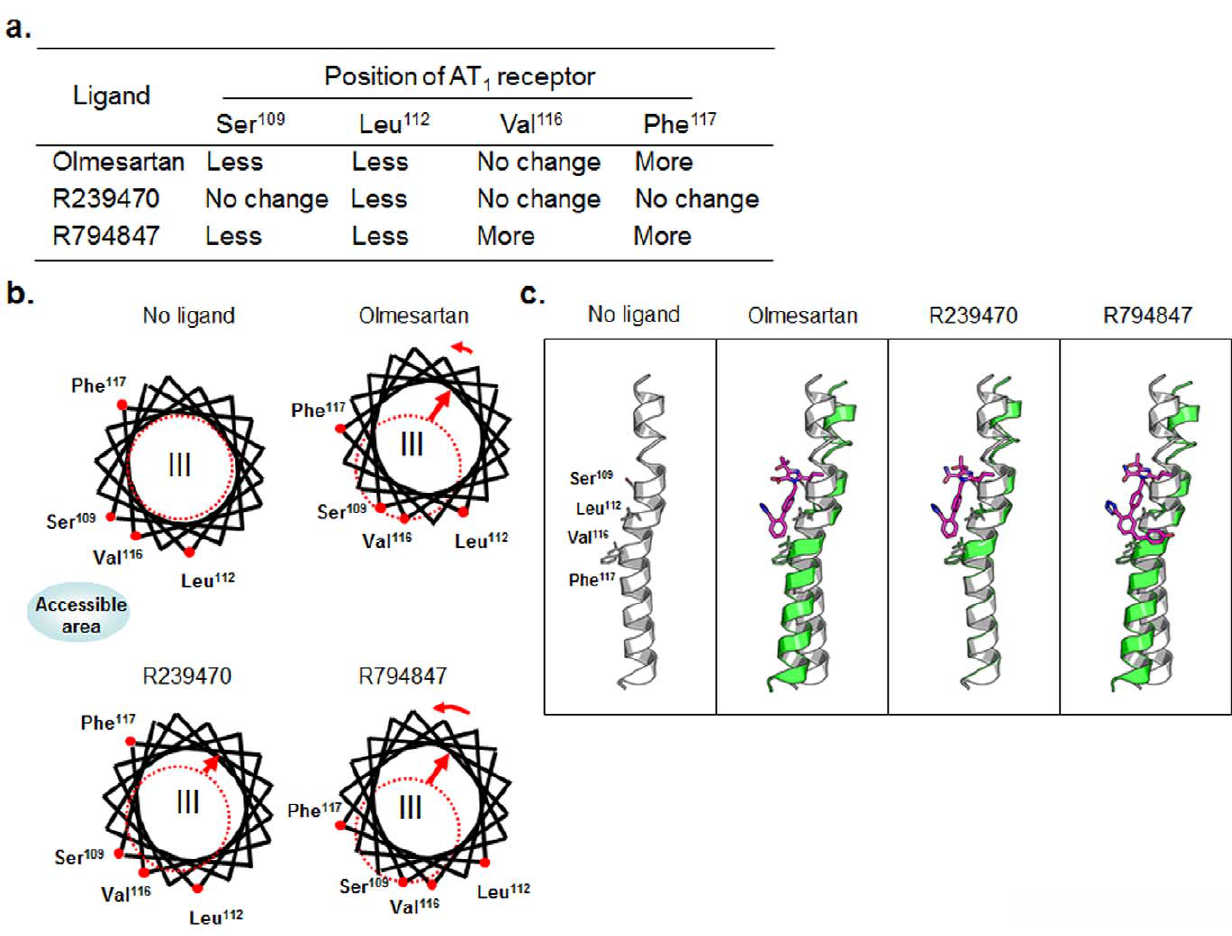
Figure 4. A. Summary of cysteine accessibilityat Ser 109 , Leu 112 , Val 116 and Phe 117 with olmesartan, R239470 and R794847 compared to ligand (-). Less and More indicate that the AT 1 receptor is less or more accessible to the ligand pocket, respectively. B. Helical wheel representation of transmenbrane (TM)3 cysteine residues for ligand (-), olmesartan, R239470 and R794847. Olmesartan induced the outward displacement and counterclockwise rotation of TM3. Dotted circle indicates the original position of TM3 without ligand. Accessible area indicates a site of ligand pocket. C. Schematic view of TM3 movement derived from the SCAM results. TM3 without ligand is shown as a gray ribbon and TM3 with various ligands is represented as green ribbons. The ligands are colored magenta. (a) without ligand, (b) olmesartan, (c) R239470, (d) R794847.